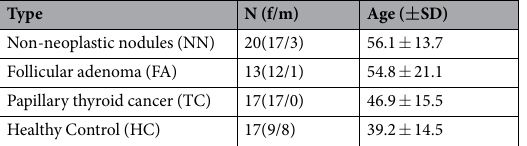
Table 1. Patients demographic data. N – number of patients, f – female, m – male, age including standard